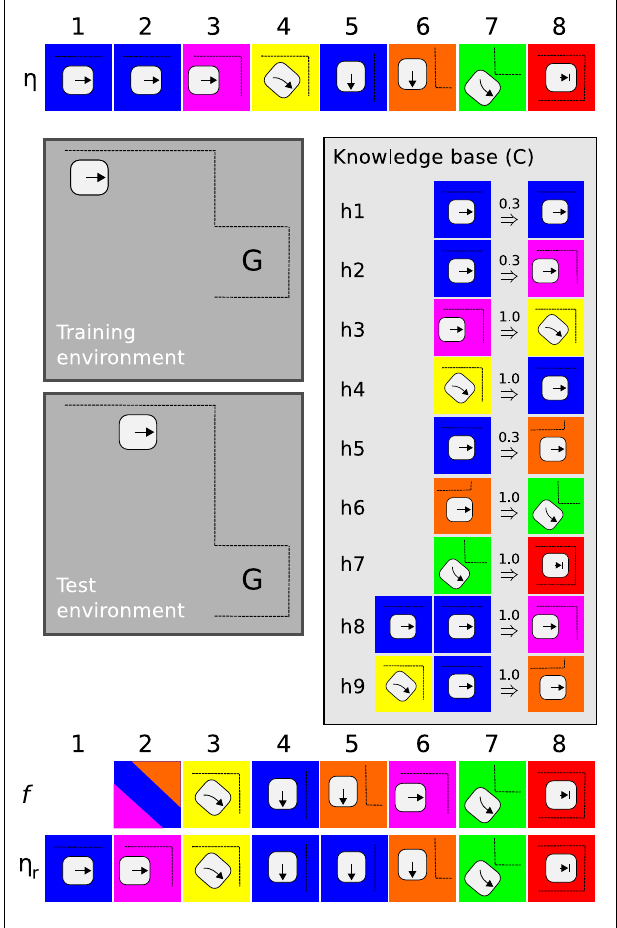
FIGURE 3 | An illustrative example of PSL . A robot, illustrated as a square with rounded corners, and an arrow indicating its direction are placed in a simple environment with dotted lines representing obstacles. G marks the goal location. Colored squares represent unique sensory–motor events. See text for